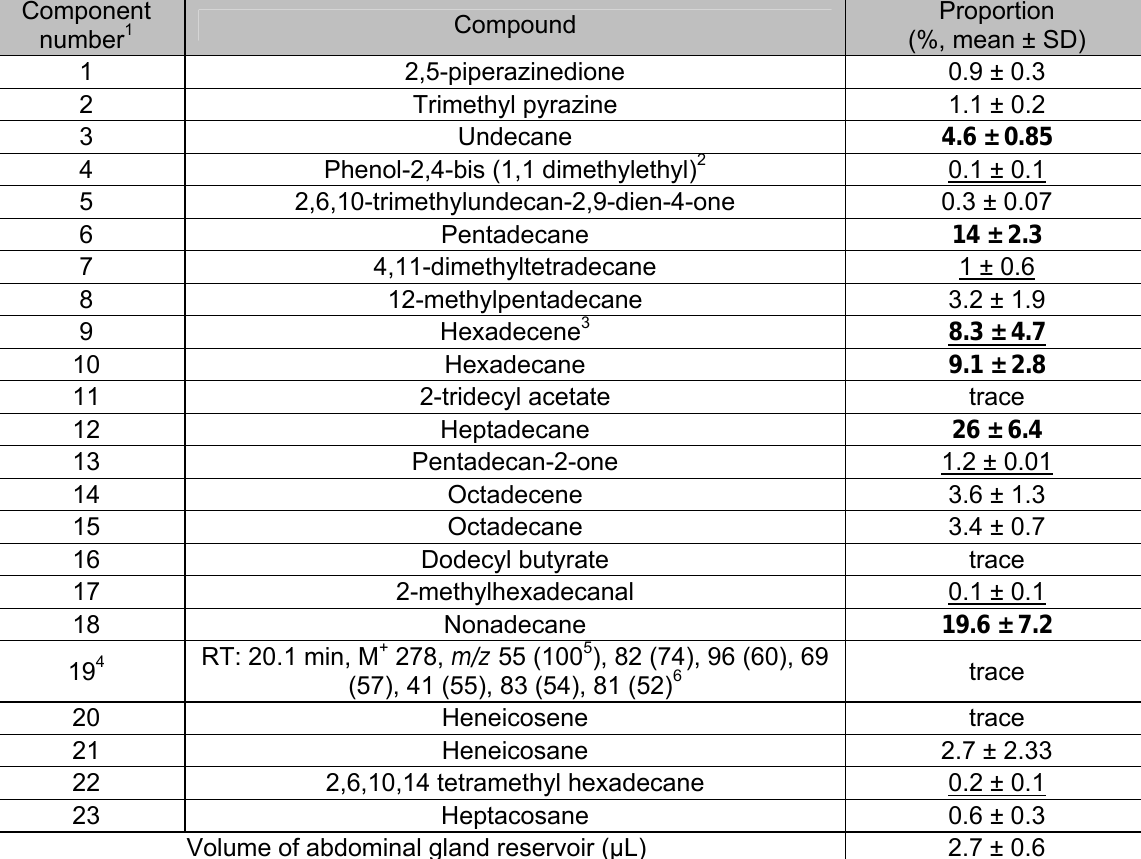
Table 1. Volume of the abdominal gland reservoir in Pachycondyla sennaarensis workers and composition of its chemical components based on GC-MS analyses (n = 7) *